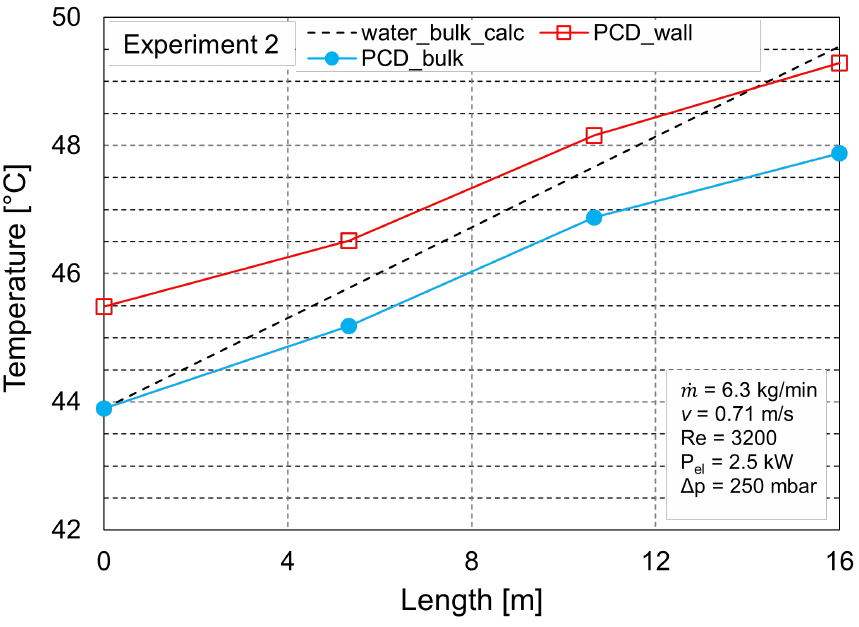
Figure 4. The evolution of the bulk and wall temperatures for the PCD in experiment 2 alongside the bulk temperatures calculated for water along the length of the